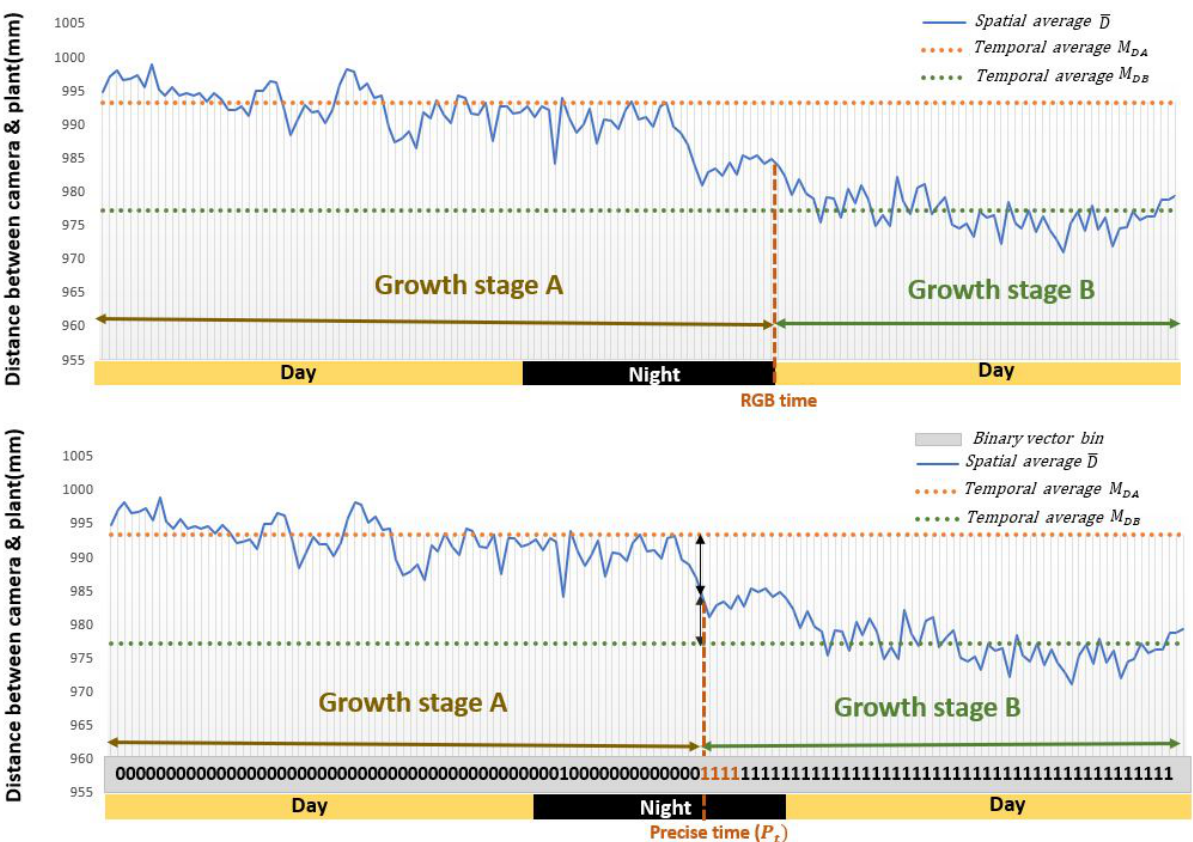
Figure 7. First row: the detection of switch from growth stage A to growth stage B using only daytime RGB images. Second row: the more precise detection of switch from growth stage A to growth stage B using the Depth pattern during the night time as proposed by Algorithm